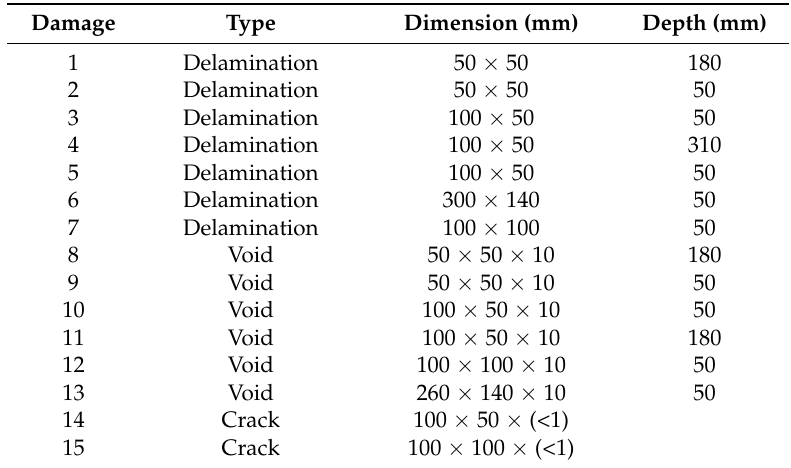
Figure 4. Artificially simulated damage and locations. Table 1. Damage types and